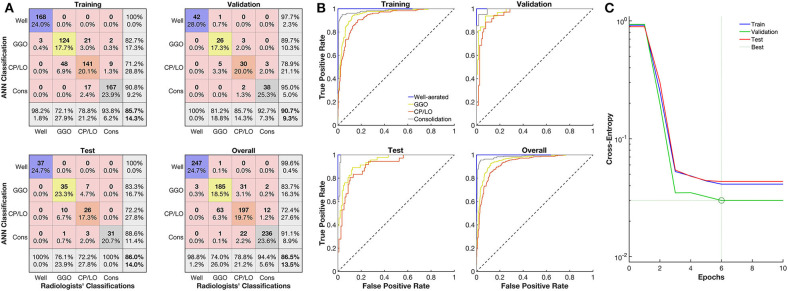
Evaluation of the artificial neural network (ANN) classifier performance. (A) Confusion matrix from the comparison between the ANN and radiologists' classification of well-aerated (blue line), ground glass opacities (GGO, yellow line), CP/LO (orange), and consolidation (gray) in training (first row and column), validation (first row, second column), test (second row, first column), and overall (second row, second column) sets. (B) Each respective receiver operator characteristic curve for well-aerated regions (blue line), GGO (yellow line), CP/LO (orange) and consolidation (gray) ANN classification in training (first row and column), validation (first row, second column), test (second row, first column), and overall (second row, second column) sets. (C) Cross-entropy at each epoch in training (blue line), validation (green line), and test (red line) sets. Dotted lines represent the best validation performance determined based on the minimization of the cross-entropy at epoch 6.